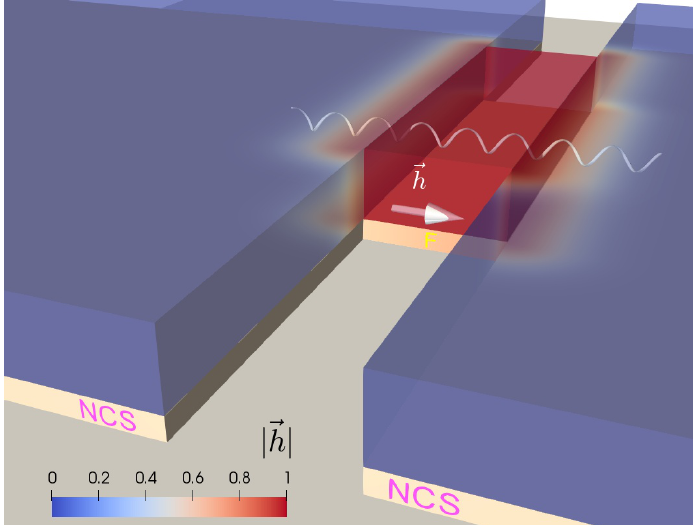
Figure 1. The Chiral Magnetic Josephson junction: two non-centrosymmetric superconductors (NCSs) are weakly linked by a uniaxial ferromagnet (F). The exchange field h of the ferromagnet, oriented across the link, induces an inversion symmetry-breaking component of the supercurrent (represented by the spiral) in the